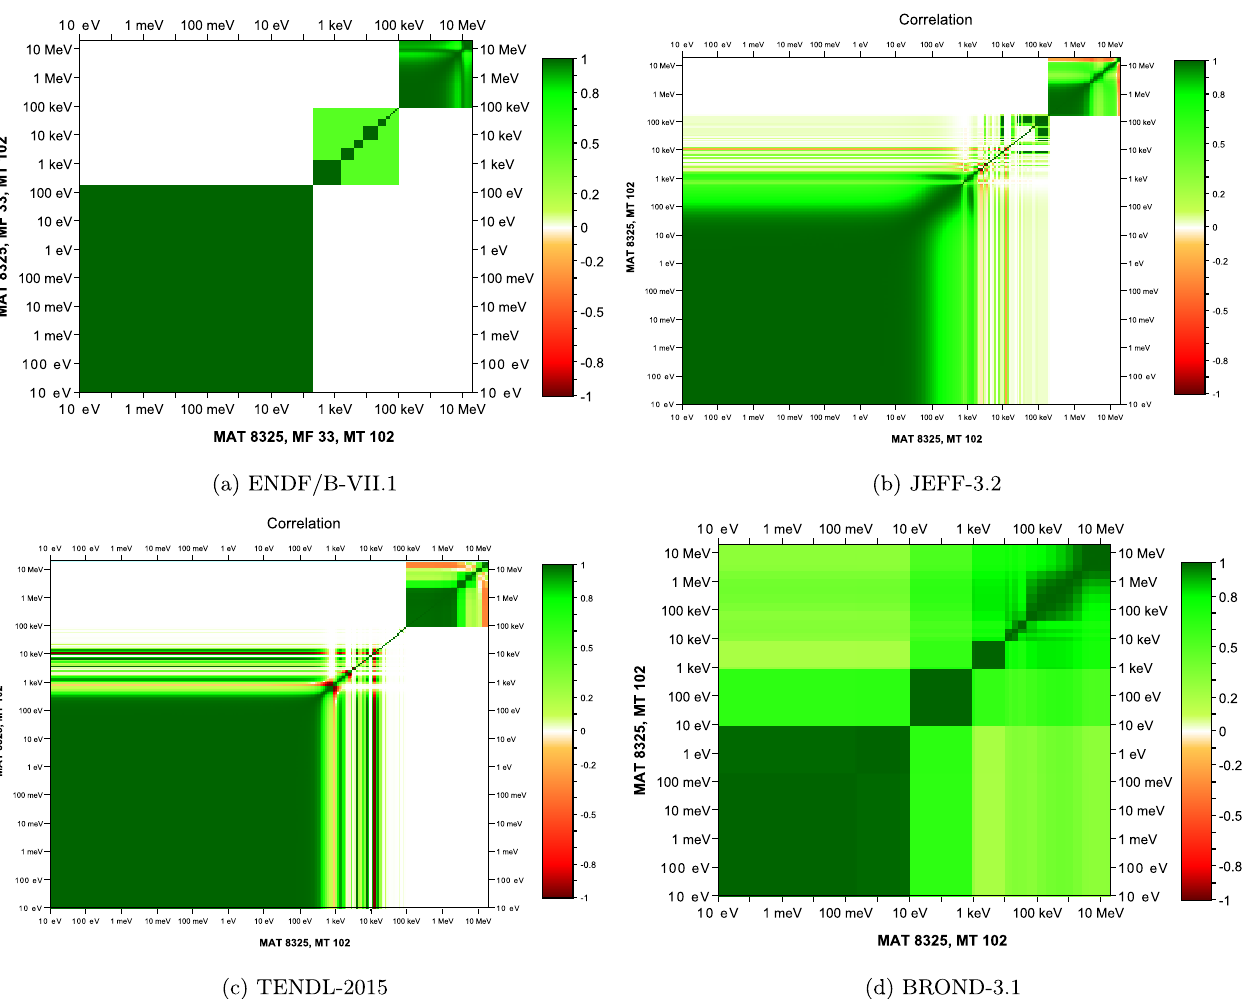
Fig. 7. Correlation matrices of the 209 Bi (n, g ) cross